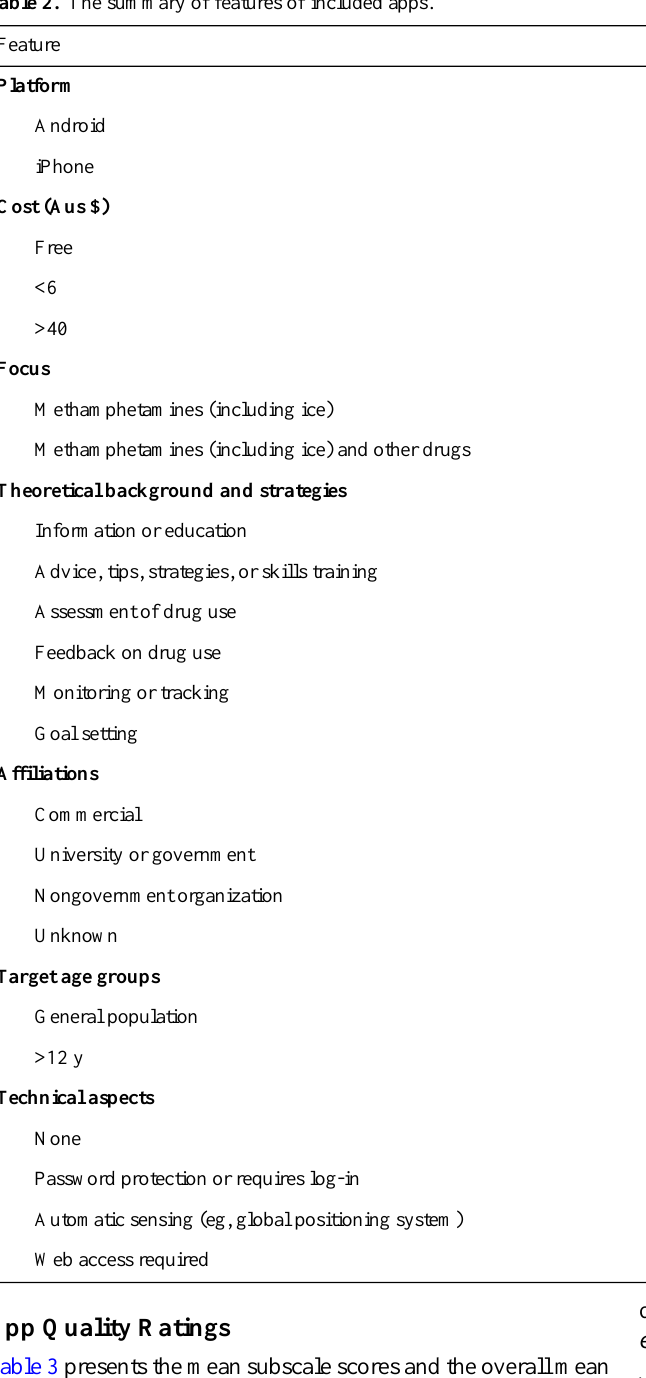
Table 2. The summary of features of included